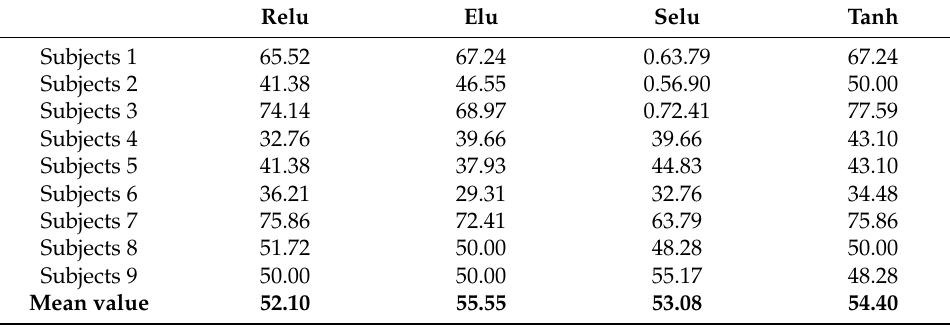
Table 4. Classification accuracy of the proposed CNN2 methods